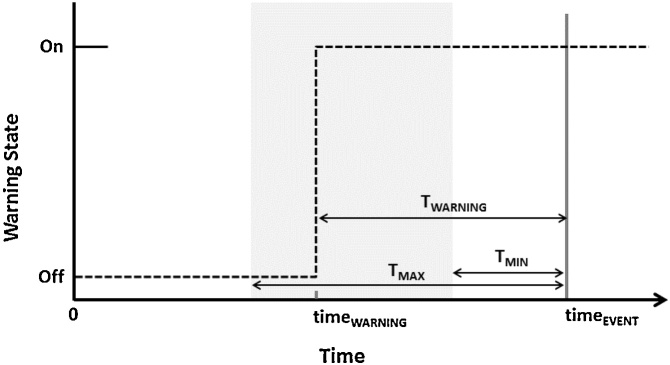
Fiducial points used to characterize a warning. Dashed lines indicate the warning state when time of critical event is timeEVENT and warning onset is timeWARNING. TWARNING is defined as the time from the warning onset (timeWARNING) to time of critical event (timeEVENT). The gray box bounded by TMAX and TMIN, indicates the maximum and minimum amount of time prior to the event when a warning is considered meaningful.TMIN and TMAX should be selected based on the event of interest that the warning system will be used for. For the non-event (control) data, timeEVENT is undefined, while for events where a warning was absent (missed) timeWARNING is undefined.